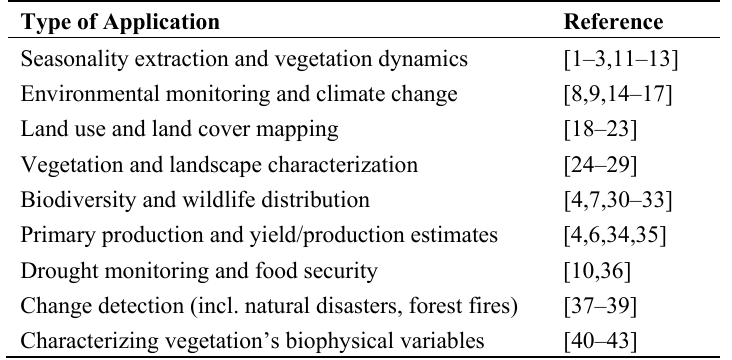
Table 1. Prominent applications building on time series of vegetation